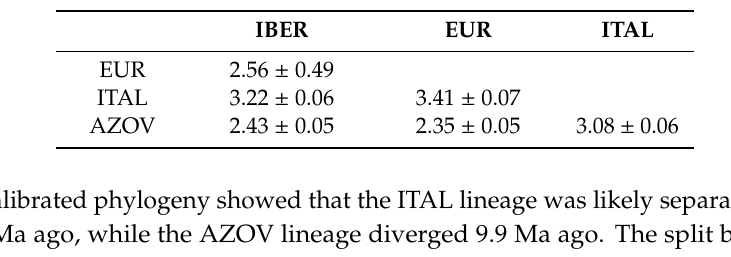
Table 2. Mean genetic divergences (uncorrected COI p-distance, %) between Anodonta anatina lineages.